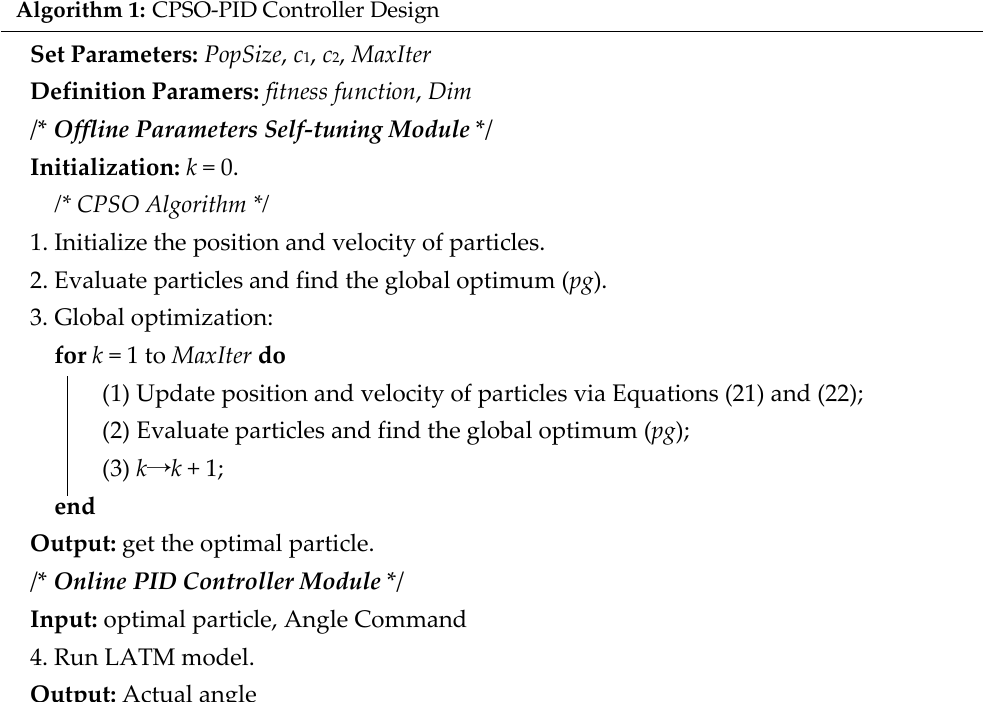
Algorithm 1: CPSO-PID Controller Design